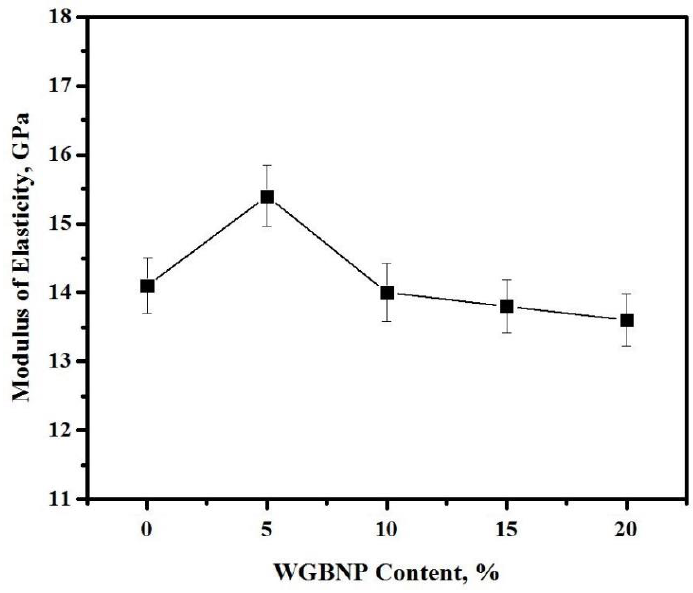
Figure 9. Influence of BGWNP content on MoE of AAMs .